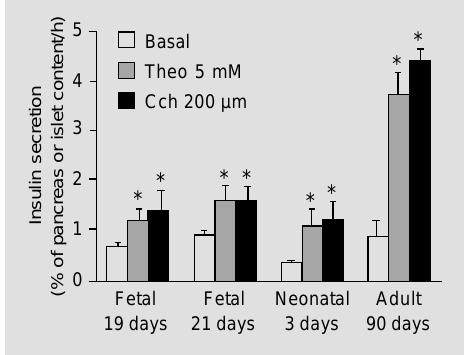
Figure 3 - Effect of 5 mM theo- phylline (Theo) and 200 µM car- bamylcholine (Cch) on insulin se- cretion. Fragments of fetal and neonatal pancreas or islets from adult rats were preincubated for 45 min at 37 o C in Krebs-bicar- bonate medium containing 5.6 mM glucose. This medium was then replaced with Krebs-bicar- bonate containing 5 mM theo- phylline or 200 µM carbamylcho- line. The columns represent the cumulative (1 h) insulin secre- tion, expressed as percentage of the total fragment or islet con- tent. The values are reported as the mean ± SEM of 6-14 experi- ments. *P<0.05 compared to basal insulin